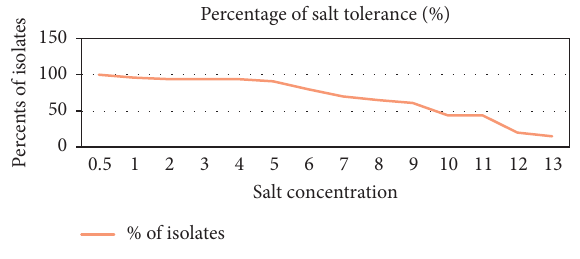
Figure 4: Salt tolerance of chickpea rhizobia.